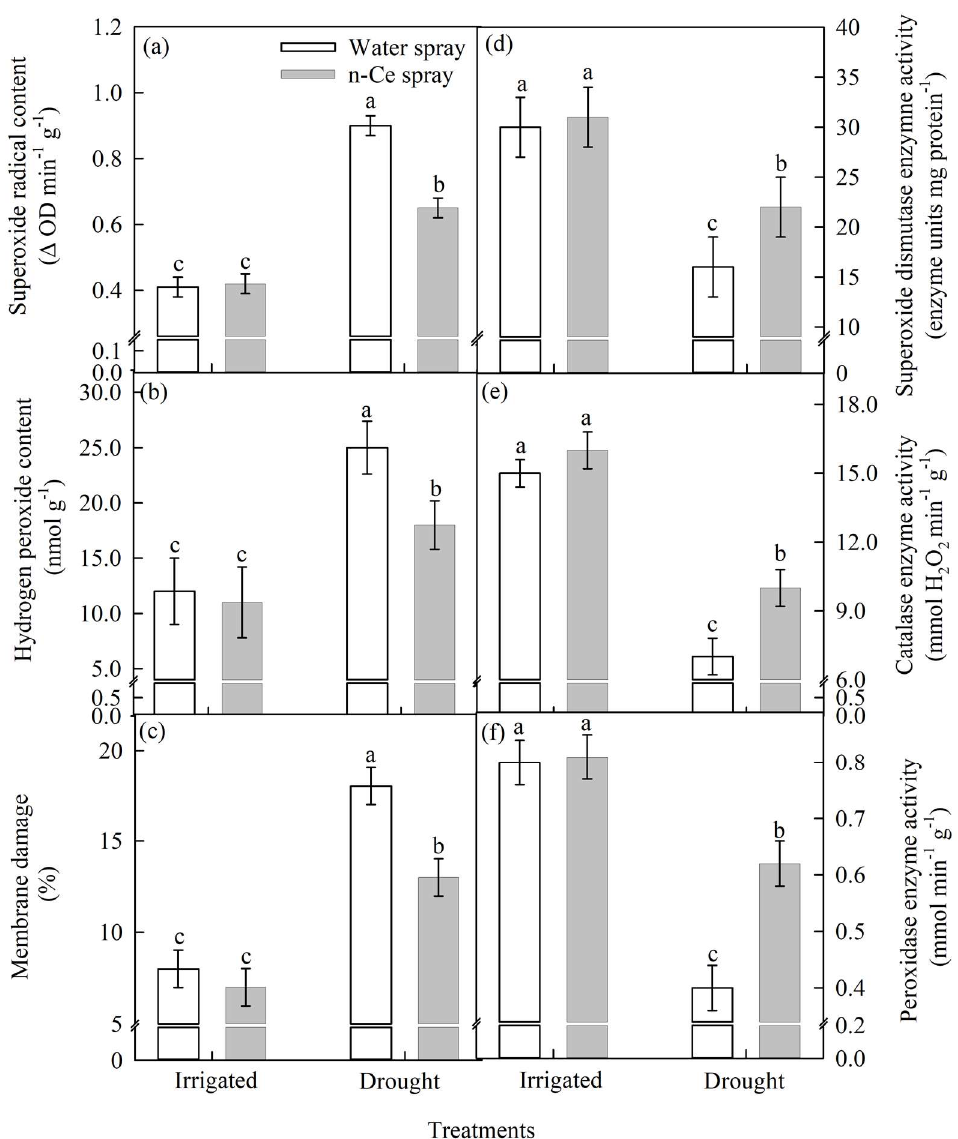
Figure 6. Effect of drought and foliar spray of nanoceria on ( a ) superoxide radical content ( OD min −1 g −1 ), ( b ) hydrogen peroxide content (nmol g −1 ), ( c ) membrane damage (%), ( d ) superoxide dismutase enzyme activity (enzyme units mg protein −1 ), ( e ) catalase enzyme activity (mmol H 2 O 2 min −1 g −1 ) and ( f ) peroxidase enzyme activity (mmol min −1 g −1 ) in mungbean (pot culture experiment). Each value is the mean ± SD of 5 independent measurements. Means with different letters are significantly different at p ≤ 0.05.